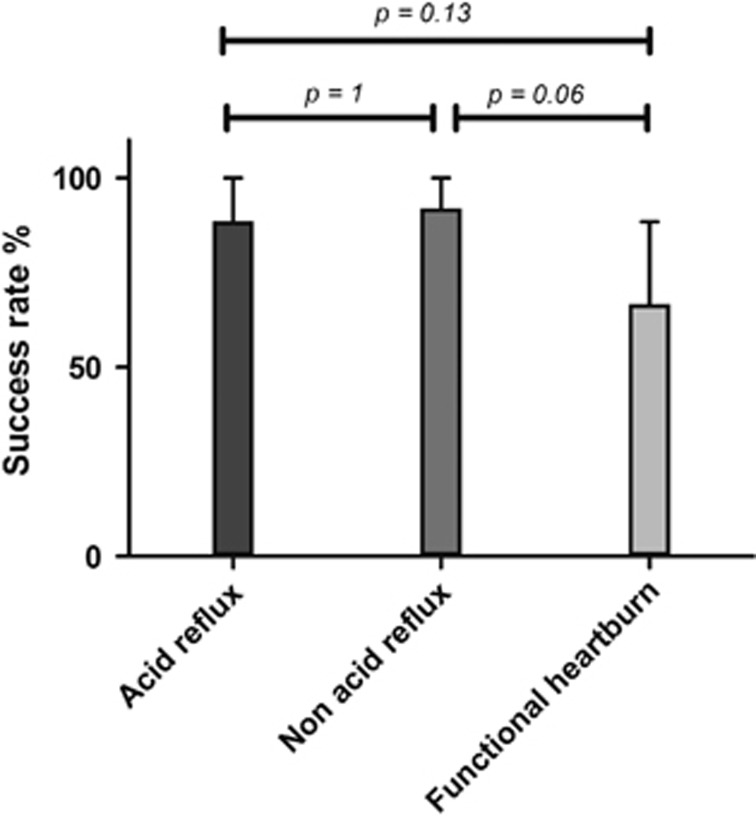
Success rates of tailored therapy according to the NERD subtypes after MII-pH monitoring. A χ2 test for trend was used. The bars represent the percentage of success, and the error bars the 95% confidence interval